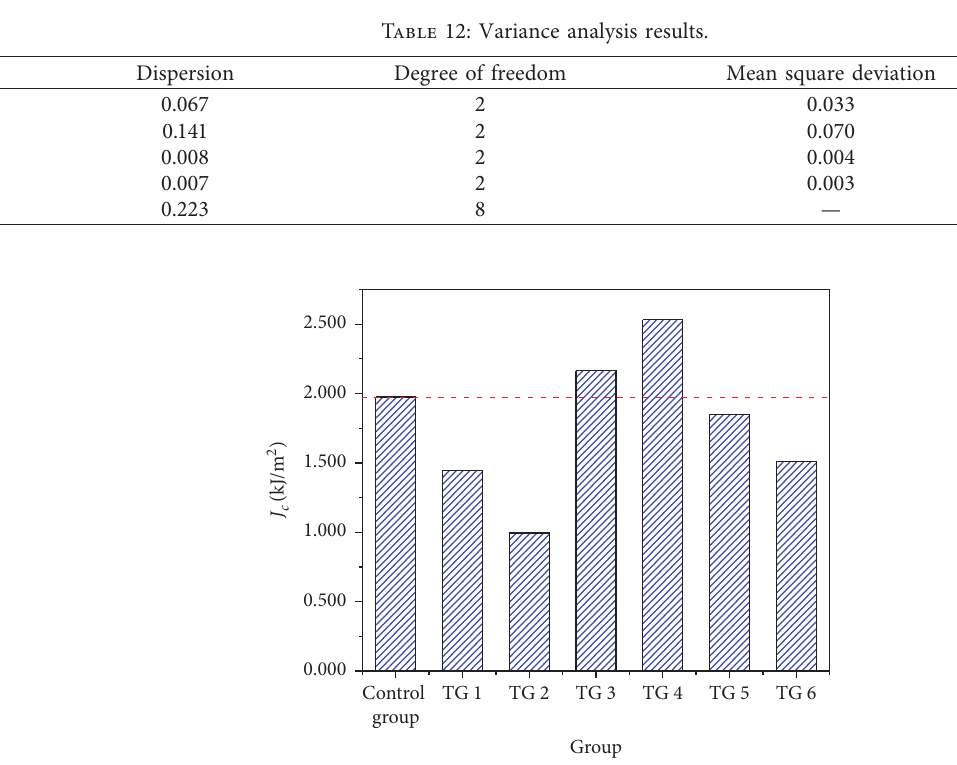
Figure 11: SCB test results of the segregated asphalt mixture.